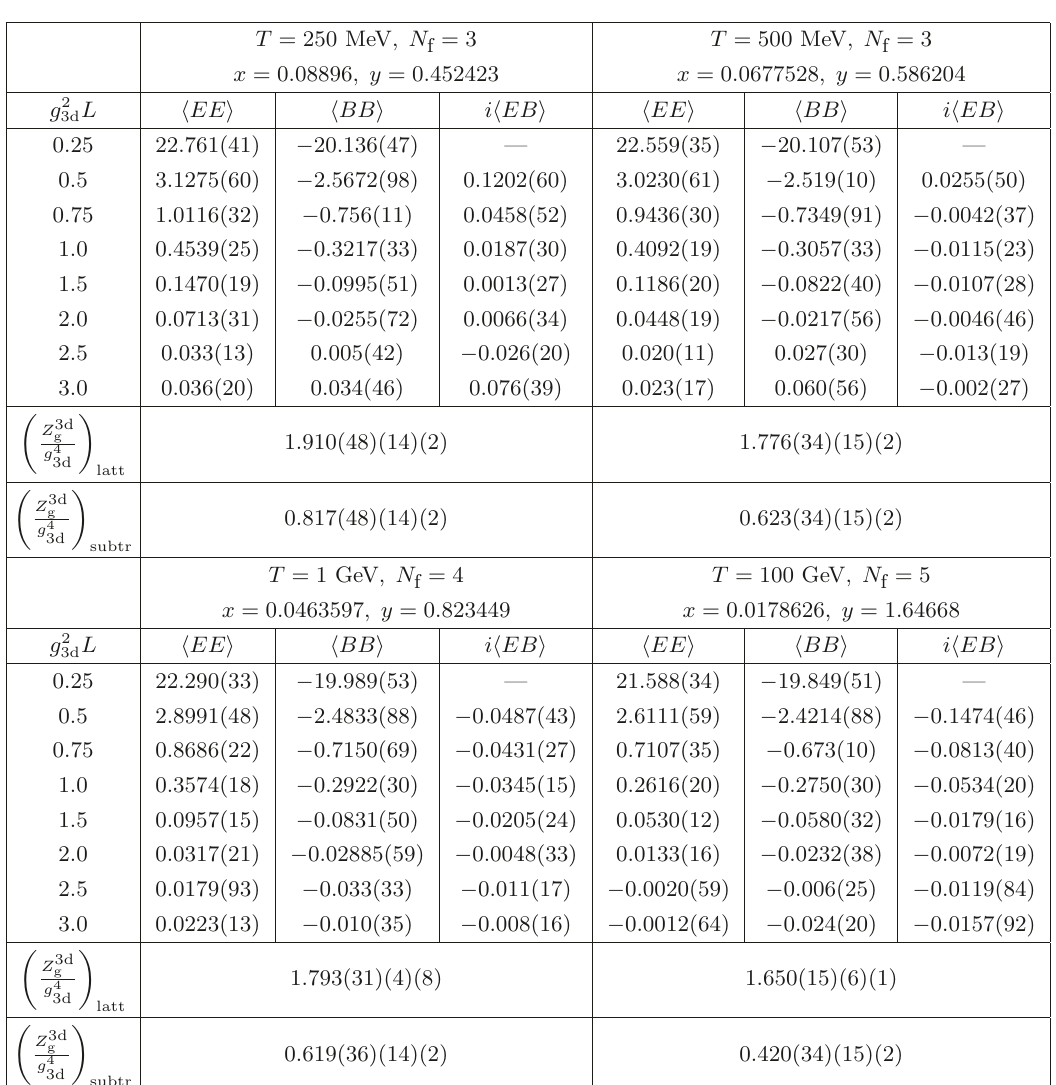
Table 1 . Continuum-extrapolated results for the correlators h EE i /g 6 at four tuples ( T, N f ) of temperature and number of massless quark flavors over a range of sep- L . ( Z 3d ) sums the integrated correlators according to (3.4) with small- g 2 arations g 2 latt g 3d